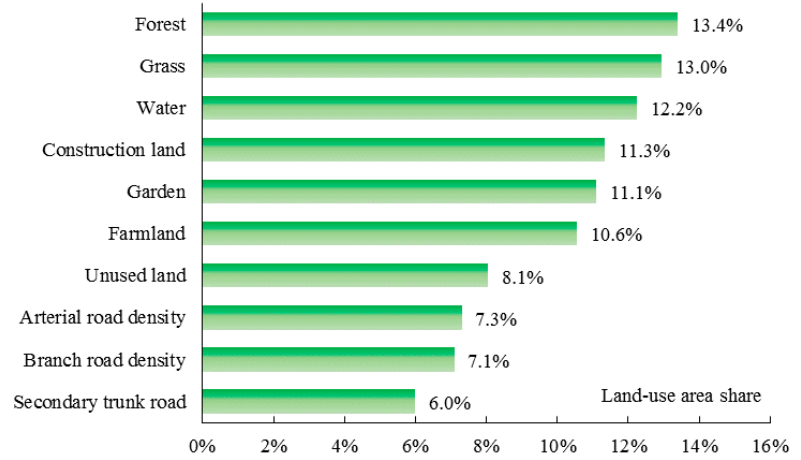
Figure 9. Relative impacts of each land-use distribution on PM 2.5 in autumn.